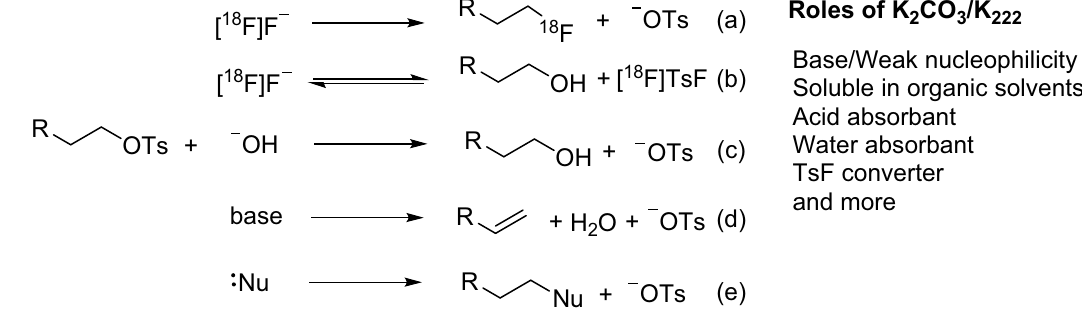
Figure 1. Conventional aliphatic nucleophilic substitution radiofluorination and its side-reactions. Besides the reactions with [ 18 F]fluoride to form the desired product ( a ) and [ 18 F]TsF ( b ), the tosylate precursor may also react with bases (e.g. hydroxide from K 2 CO 3 and residual water) to form the alcohol ( c ) and the eliminated product ( d ) and with other nucleophiles (e.g. chloride from QMA cartridge and nucleophilic atom(s) on